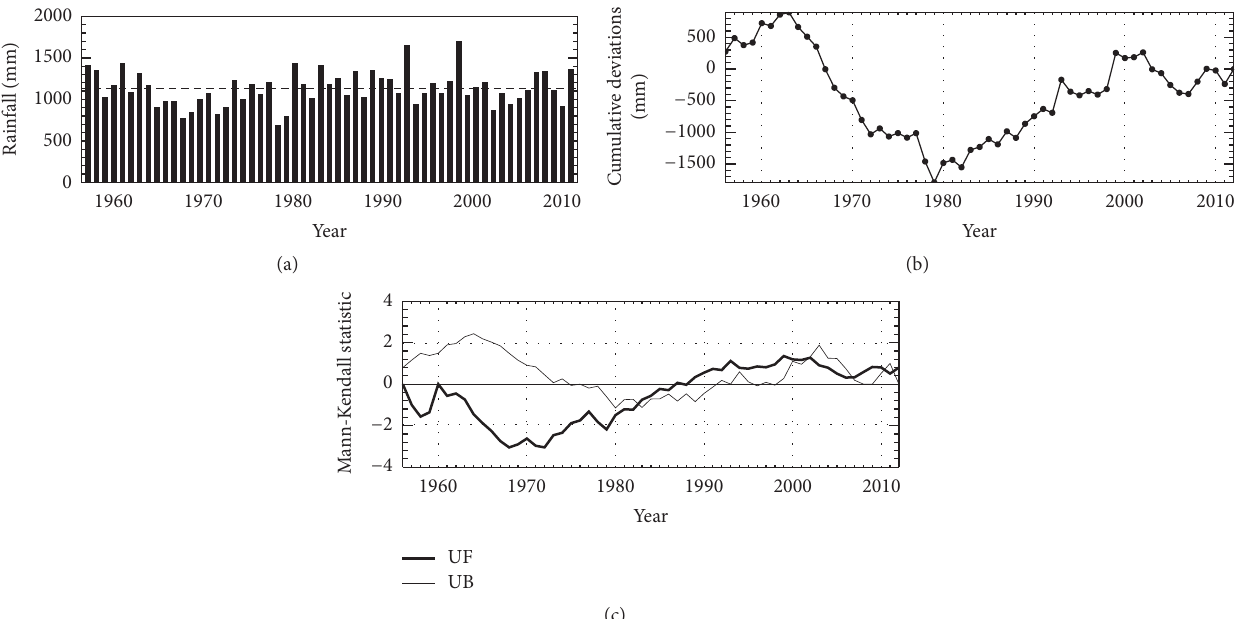
Figure 2: (a) Time series of total annual rainfall at Dongshan weather station (1956–2012). The horizontal line shows the average rainfall throughout the studied period. (b) Cumulative sum of deviations from the average rainfall. (c) Results of the Mann–Kendall test. The solid line is the UF statistic and the thin line is the retrograde series